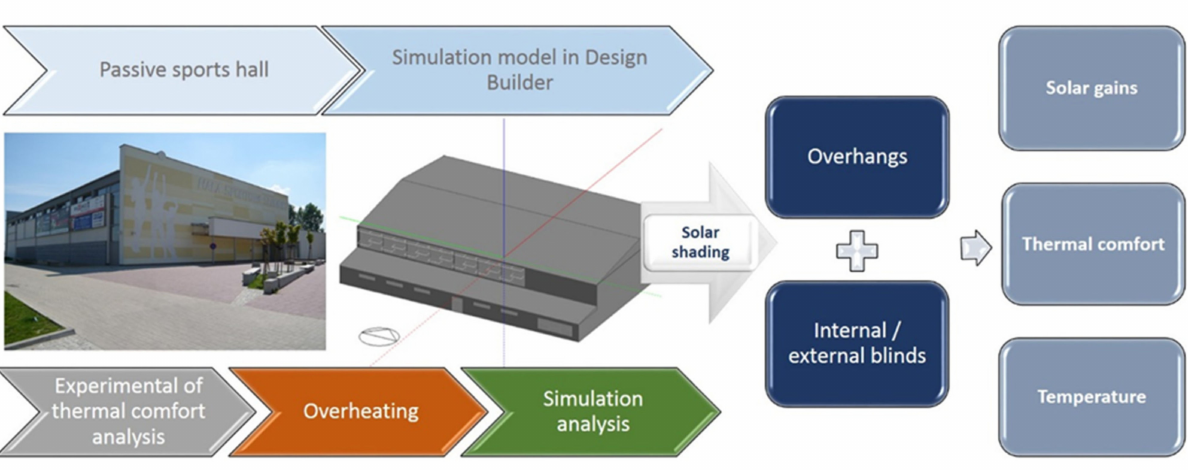
Figure 7. Graphical scheme of the experimental simulation analysis of the sports hall in